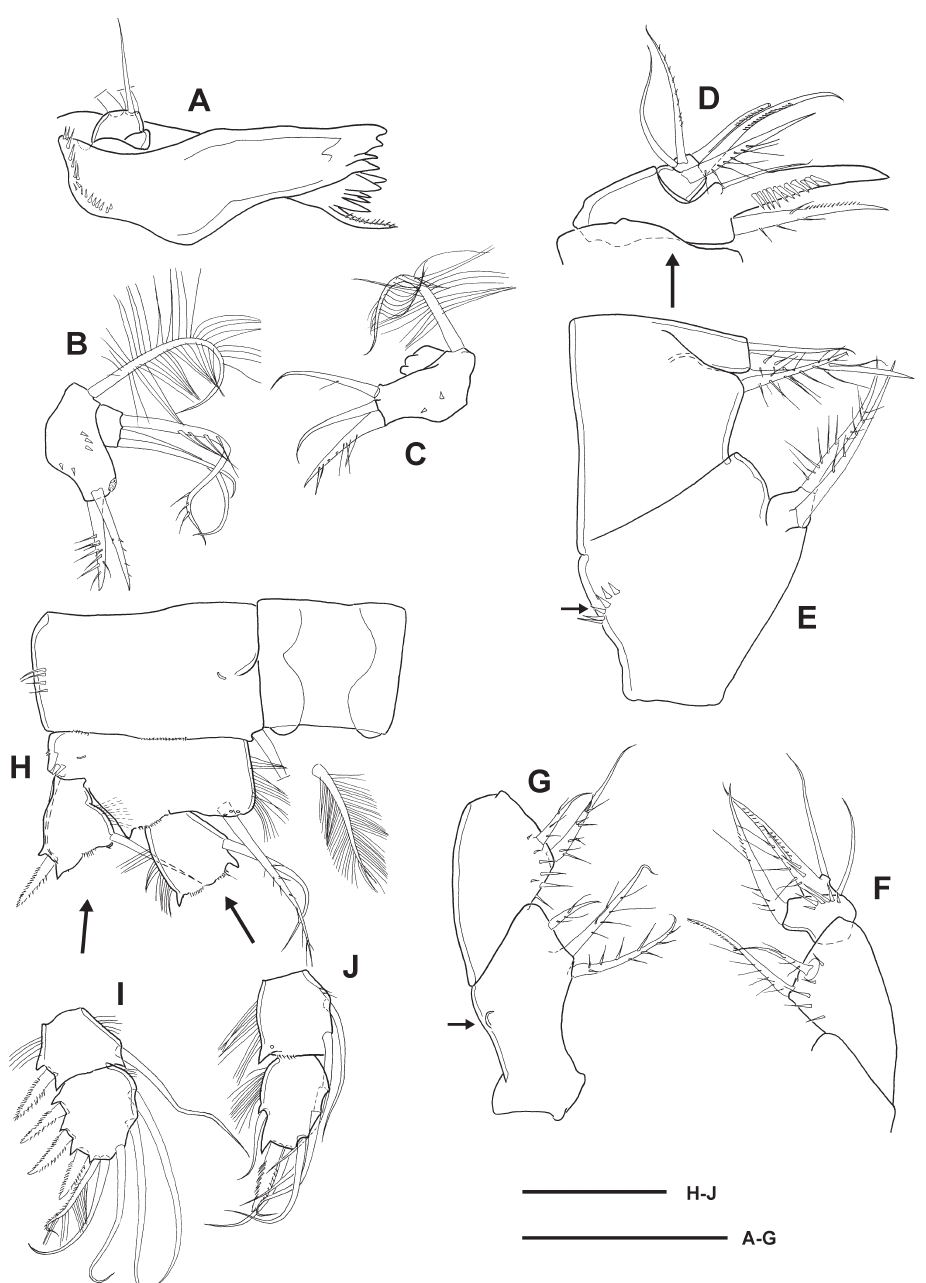
Fig. 9. Eucyclops agiloides (G.O. Sars,1909), ♀ (Lake Tanganyika, Kirando; NHM). A . Mandible, anterior view. B−C . Variation of the spinule ornamentation of the maxillulary palp. B . ♀-1 (one apical seta is broken off). C . ♀-3. D . Maxillar basipodite and two-segmented endopodite, caudal view. E . Maxillar syncoxopodite, caudal view – note short transverse row of spinules near lateral margin (arrow). F . Maxilliped, basipodite and two-segmented endopodite, frontal view. G . Maxilliped, syncoxopodite and basipodite, frontal view – note the flap-like structure (arrow). H . Leg 1, protopodite and first exopodal and endopodal segments, frontal view (coxopodal seta is figured separately). I . Leg 1, second and third exopodal segments, frontal view. J . Leg 1, second and third endopodal segments, frontal view. A shows ♀-2; B, D–E, G−J show ♀-1; C, F show ♀-3. Scale bars: A−J = 50